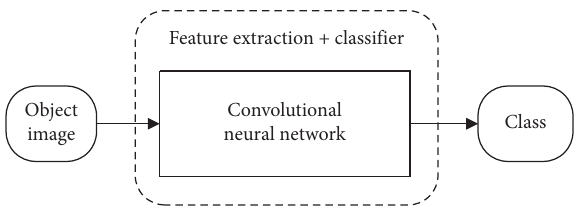
Figure 6: Vision pipeline of the passenger recognition systems based on ConvNets.